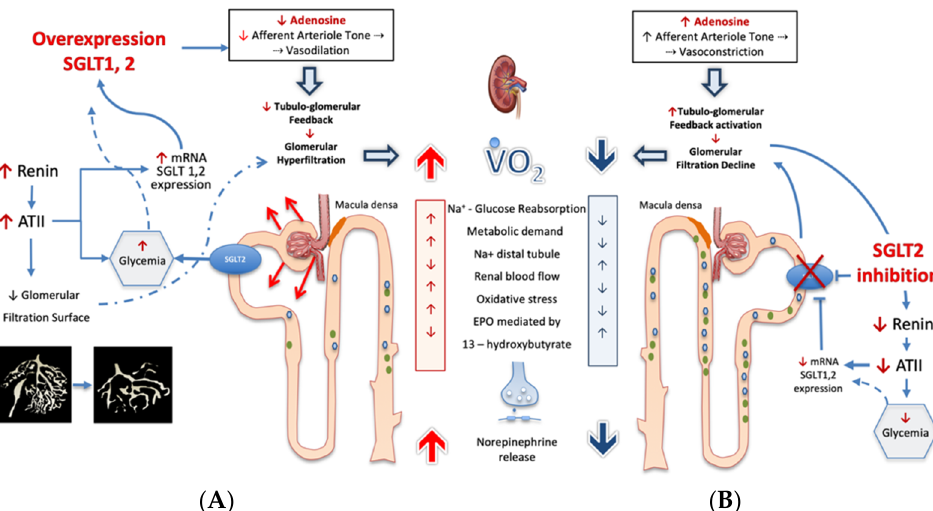
Figure 3. Under conditions of ambient hyperglycemia (panel ( A )), sodium-glucose co-transporter 2 activity (SGLT2) is increased, thereby reducing the juxtaglomerular apparatus delivery of Na + . This affects the tubuloglomerular feedback mechanisms, as the concentration of Na + that transits across the juxtaglomerular apparatus establishes the adenosine triphosphate (ATP) release and its breakdown to adenosine. Local adenosine concentration acts by vaso-constricting afferent arteriole. Thus, any adenosine concentration decrease may impact the appropriate regulation of glomerular blood flow and of glomerular filtration pressure and, therefore, of renal metabolic work. An unfavorable consequence of the higher metabolic work is the increased cortical oxidative stress-induced tubulointerstitial damage that causes a fall in erythropoietin production [9]. The adenosine generation in the juxtaglomerular apparatus is linked to a large network of biological effects such as the control of renin release; therefore, a decreased breakdown of ATP in the juxtaglomerular apparatus may lead to enhanced ATII generation. Angiotensin II not only affects the circulation balance systemically, but also compromises the glomerulotubular balance by restraining the efferent arteriole section and the glomerular capillary surface area. All together, these responses account for the incremental neural transmitter release, leading to the exceedingly high renal norepinephrine spillover occurring in heart failure progression [11]. Under these conditions, the SGLT2 inhibition ( B ), by inducing glucoresis and natriuresis, is able to re-establish the distal tubular flow and Na + delivery to the juxtaglomerular apparatus. In this way, SGLT2 inhibition restores local adenosine generation that reestablishes the afferent arteriole tone, leading to lower filtration pressure and to lower metabolic work while it restores control on neuroendocrine pathway. See text for details. SGLT2 = sodium-glucose co-transporter-2; VO2 = Oxygen consumption; ATII = angiotensin II; EPO = erythropoietin. It is also important to recall that adenosine not only balances glomerular